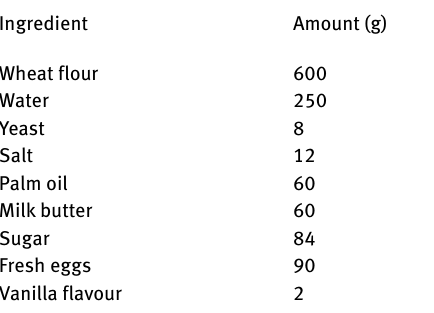
Table 3: Recipe of a typical brioche dough